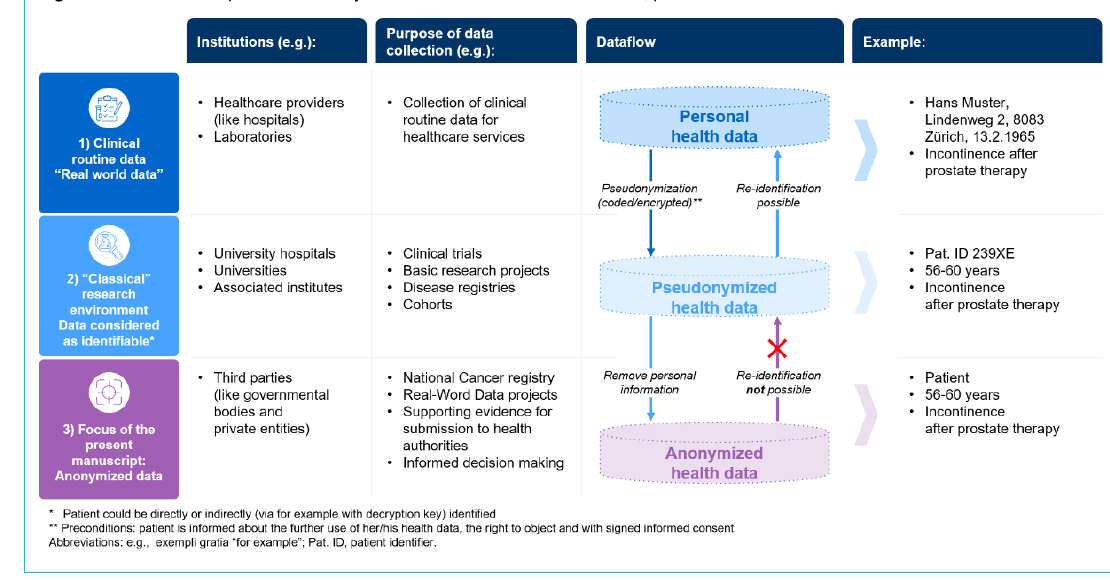
Figure 1: Dataflow: from personal to anonymised health data. Abbreviation: PHC, personalised